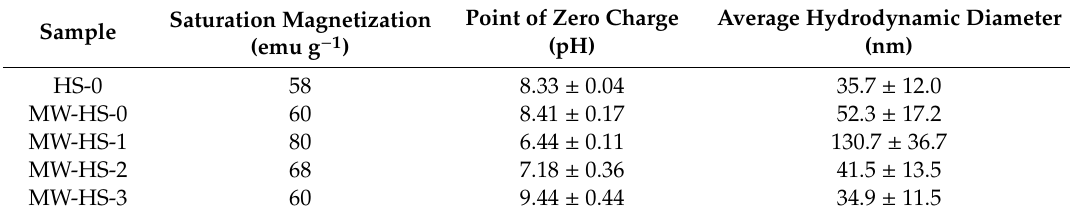
Table 2. Magnetic and colloidal properties of the obtained